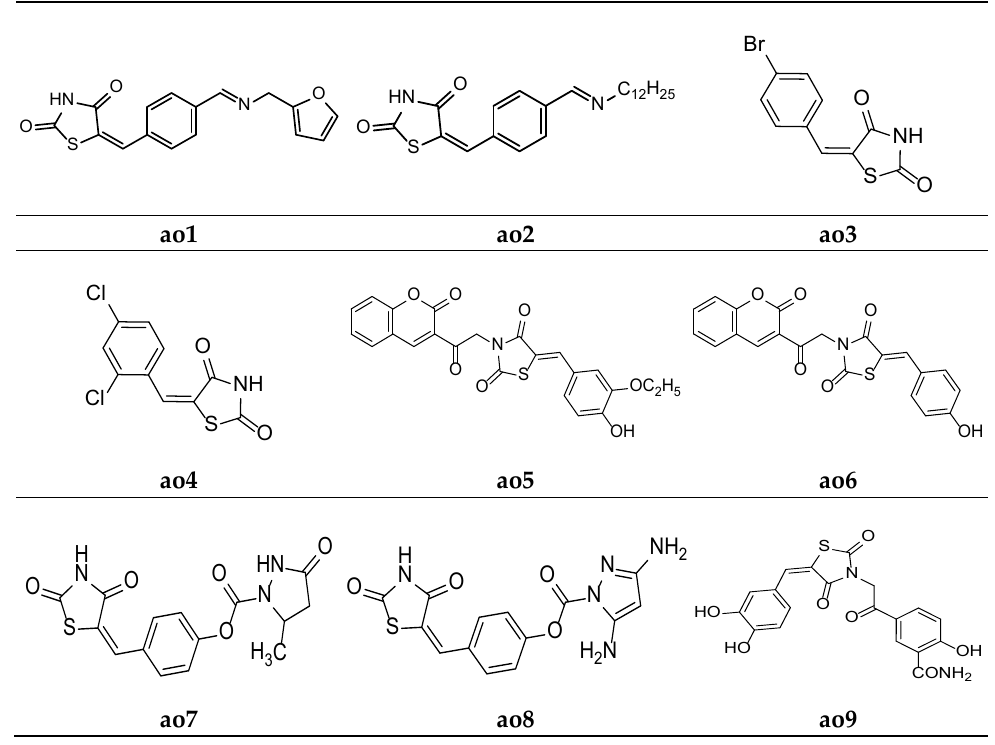
Figure 18. Molecular structures of the compounds ( ao1 – ao9 ). Table 55. Antioxidant activity of the compounds (ao3 – ao4). Comp.